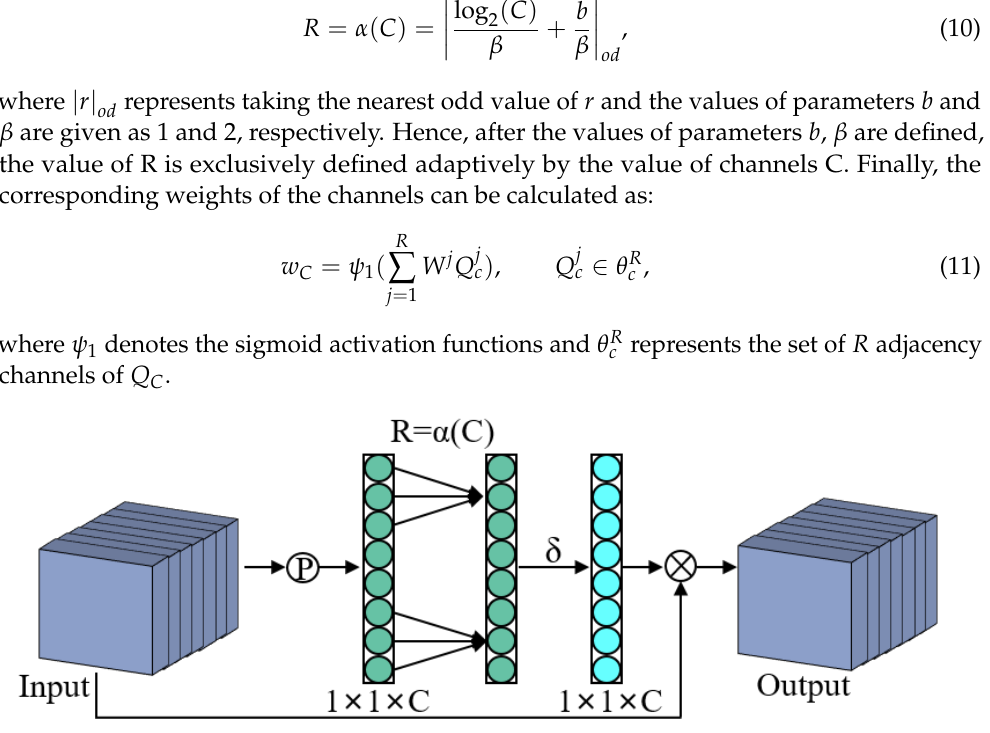
Figure 5. The schematic of the structure of ECA. Here, I stands for the input feature map of the ECA, C represents the number of channels of I , P denotes the set of features obtained from the input feature map I after AP, and (cid:78) denotes the multiplication of